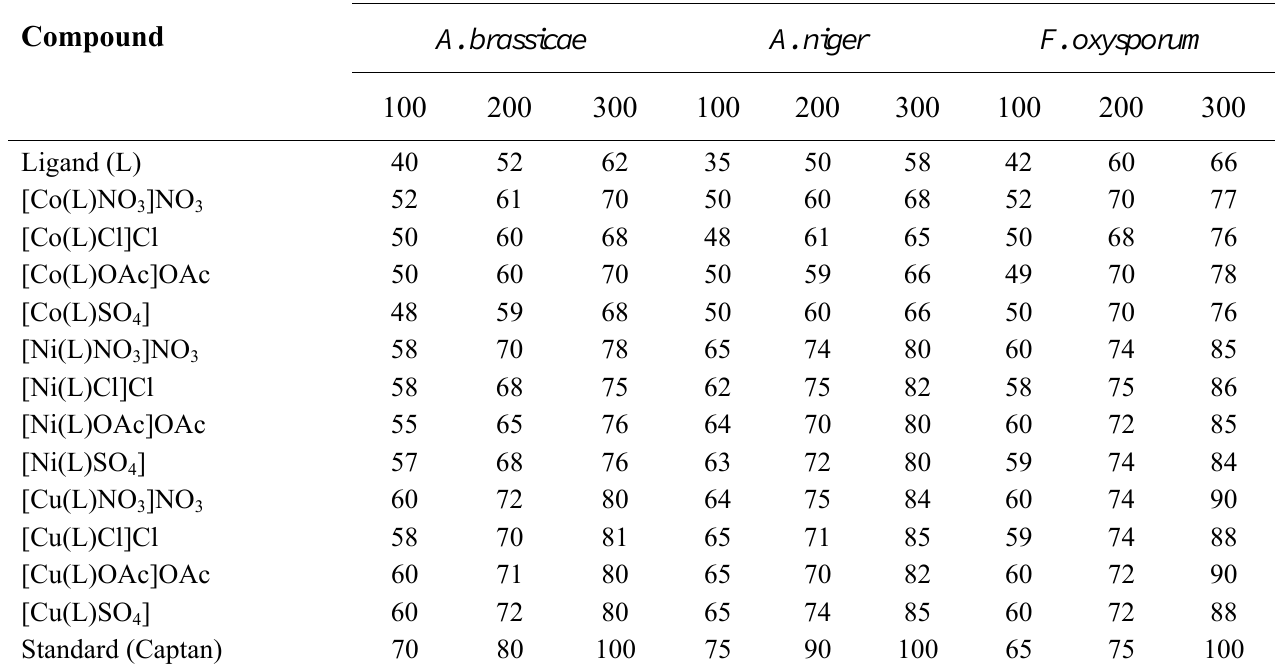
Table 6. Antifungal activity data of the compounds.